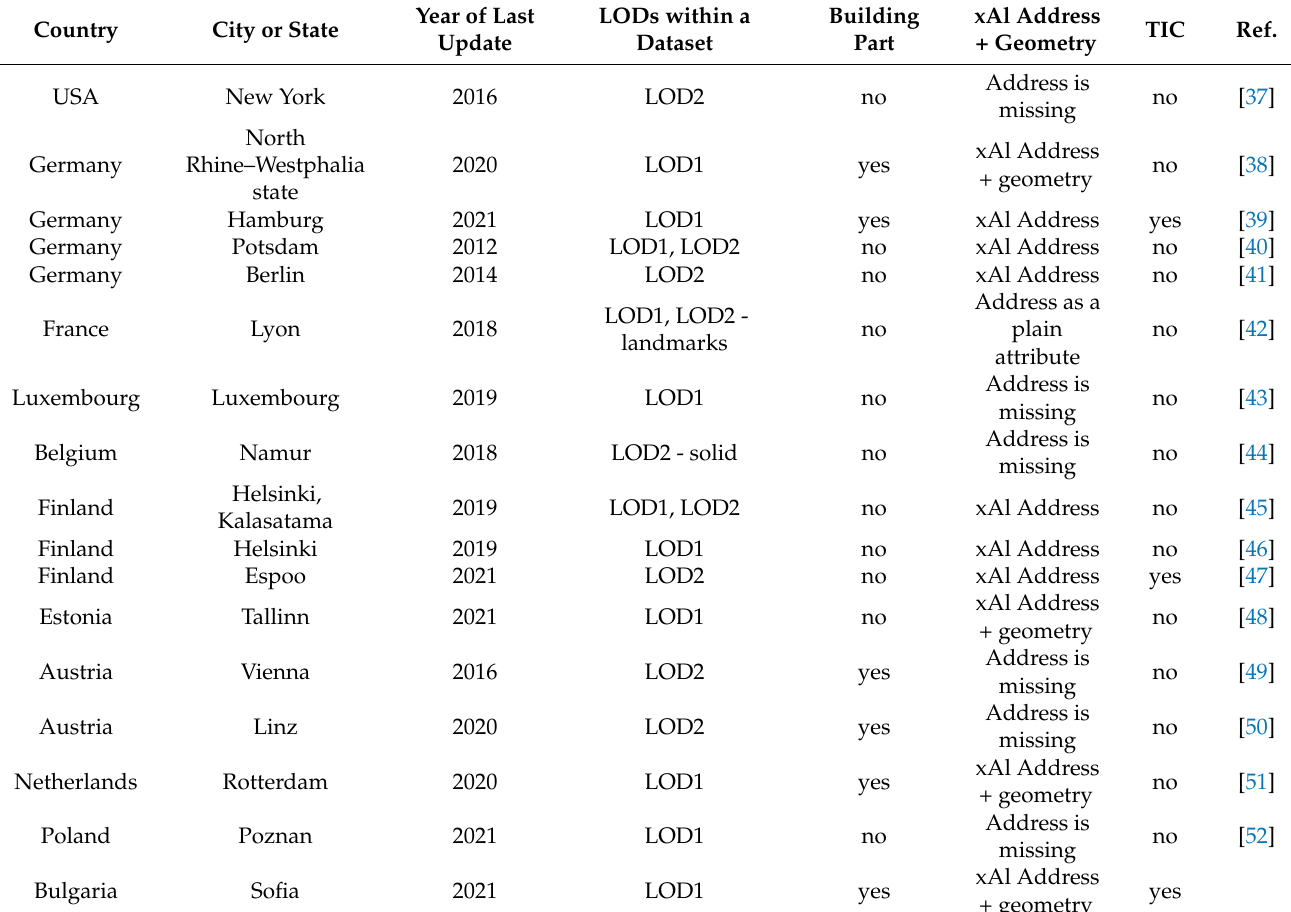
Table 1. 3D city models in CityGML